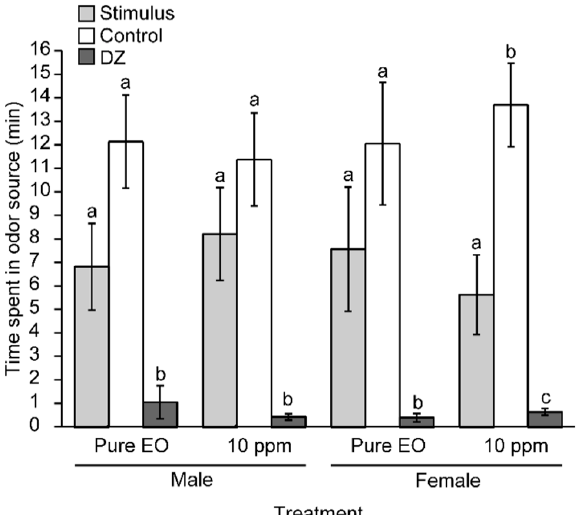
Figure 1. Average time spent (min ± SE) by A. superciliosus in the olfactometer arms containing pure EO and diluted P. uviferum heartwood EO (2 μ L and 50 μ L of 10 mg/L EO, i.e., 56.6 mg/cm 3 and 1.58 × 10 − 2 mg/cm 3 , respectively). Control: purified air, DZ: decision zone. The lines on the bars indicate the standard error. Different letters indicate significant differences based on the non-parametric Friedman test followed by the Conover-Inman test ( p ≤ 0.05) N = 24.